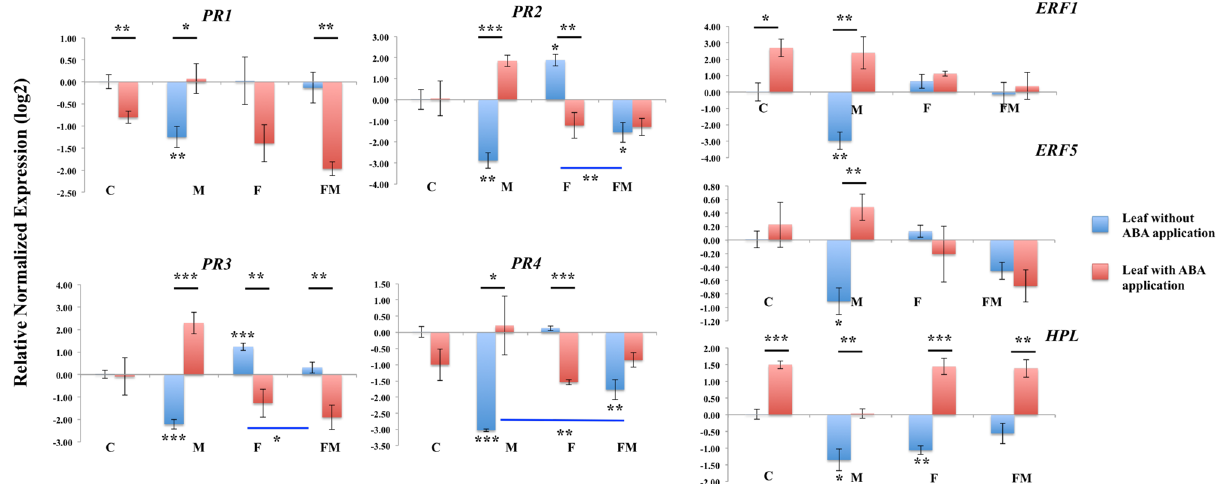
Figure 4. Relative expression of genes involved in plant immune responses in bean leaves. RNA was extracted at 14 days from bean leaves in un-inoculated control (C), colonized by M. robertsii (M), F. solani (F), and M. robertsii together with F. solani (FM). For each gene, the expression level in un-inoculated control bean leaf was set to 1. Standard errors are shown. Data were analyzed with standard t -test in Bio-Rad CFX Manager software. Statistical differences are shown; * P < 0.05; ** P < 0.01; *** P < 0.001. Asterisk alone indicates significant difference in gene expression in the tested group when compared to that in the un-inoculated control. Asterisk above black line indicates significant differences in gene expression in the plant with exogenous ABA application compared to that in the corresponding plant without ABA application. Asterisk above blue line indicates significant difference in gene expression in the plant co-colonized by M. robertsii and F. solani compared to that in the plant colonized only by F. solani or M. robertsii . Pathogenesis related protein 1 ( PR1 ), Beta 1–3 endoglucanase ( PR2 ), Chitinase class I ( PR3 ), Pathogenesis related protein 4 ( PR4 ), Ethylene-Responsive Transcription Factor 1 ( ERF1 ), Ethylene-Responsive Transcription factor 5 ( ERF5 ), and Hydroperoxide lyase ( HPL ). The experiment was repeated twice with similar